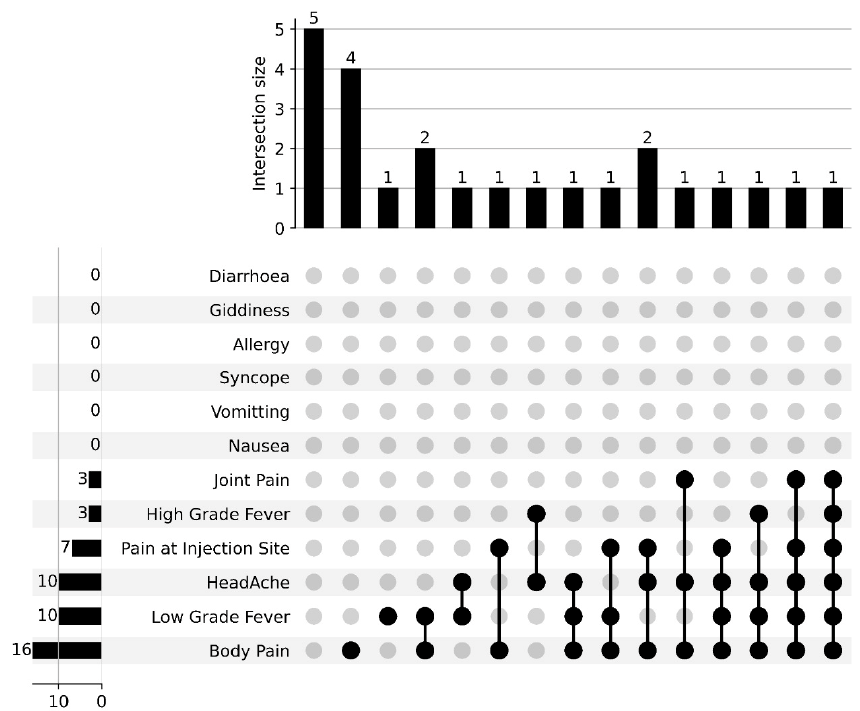
Figure 3. Upset plot representing reported side-effects and co-existence of symptoms after the second dose of the vaccine. The values represent the number of individuals experiencing a symptom category or combination of categories. Black lines link multiple symptoms indicated by black dots .